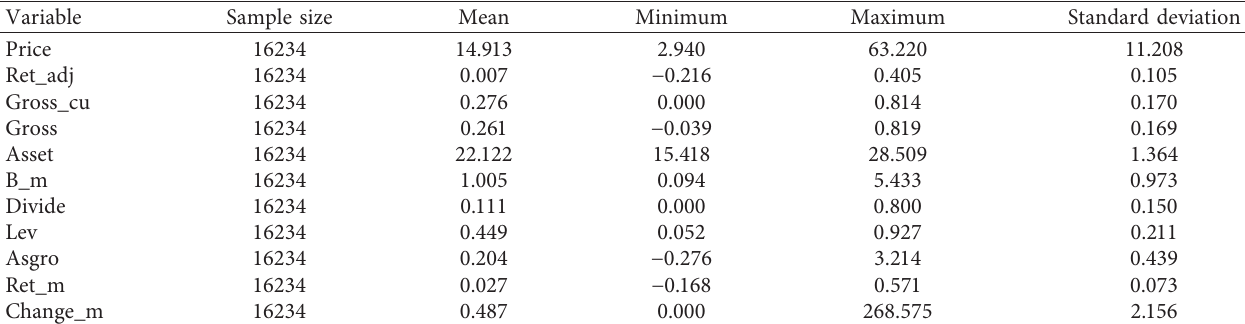
Table 2: Descriptive statistics of main variables.